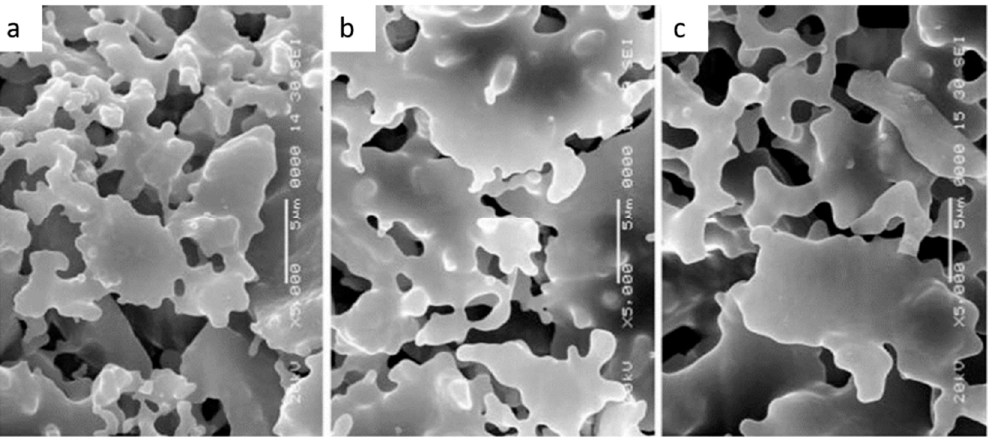
Figure 7. SEM image of the surface of RHA (rice husk ash) derived silica-based hollow fiber ceramic membranes at different sintering temperatures: ( a ) 1200 °C; ( b ) 1300 °C; ( c ) 1400 °C. Increasing sintering temperature leads to higher shrinkage and lower porosity (adapted from ref. [140] with permission from Elsevier).